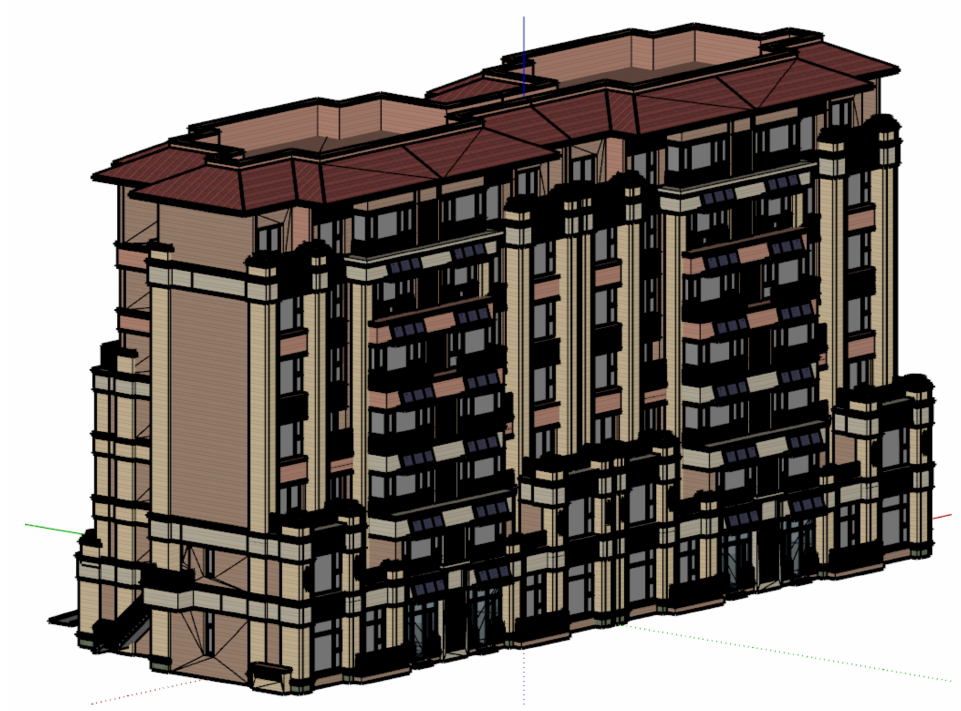
Figure 4. 3D building update model (Back).